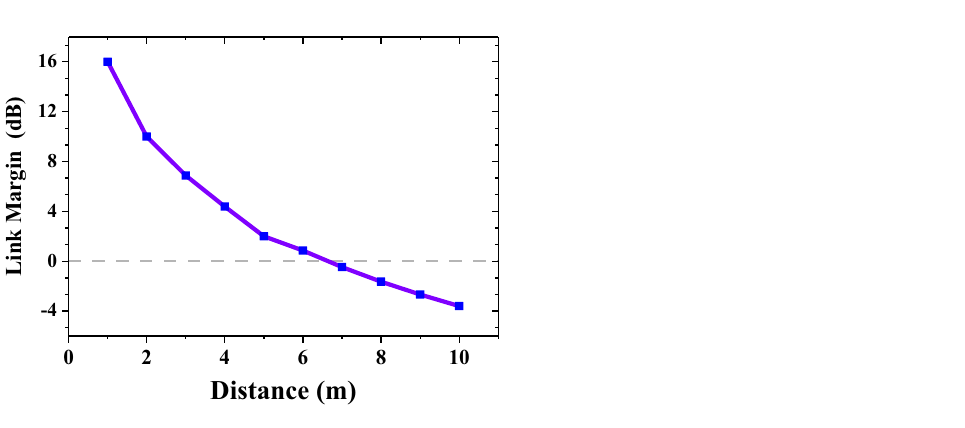
Figure 14. The communication link budget of the antenna at 2.45 GHz.